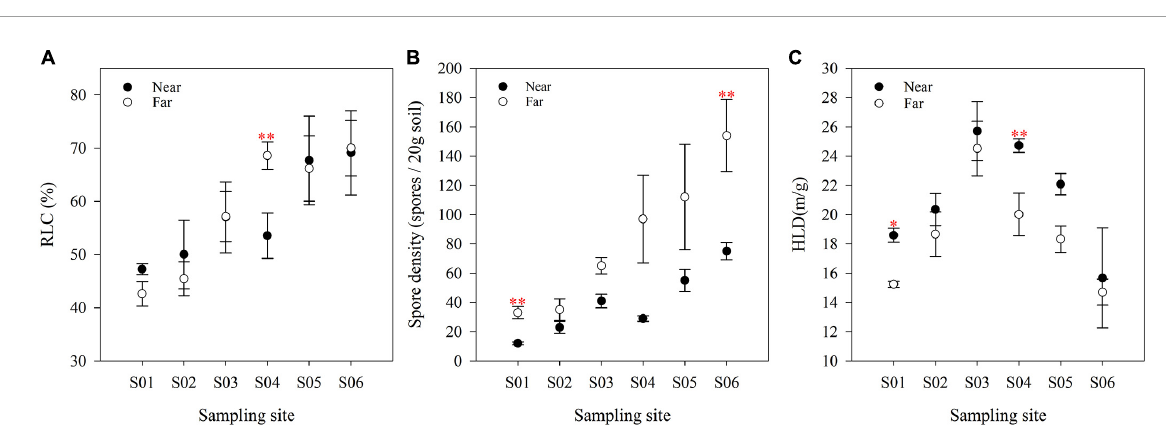
FIGURE4 The RLC (A) , spore density (B) and HLD (C) of soils at various sites in the riparian zone. The data are means ± SE ( n = 3). Significant differences between the near-bank and the far-bank samples at the same sampling site were determined based on the Kruskal-Wallis Test (* P < 0. 05; ** P < 0.01; *** P <